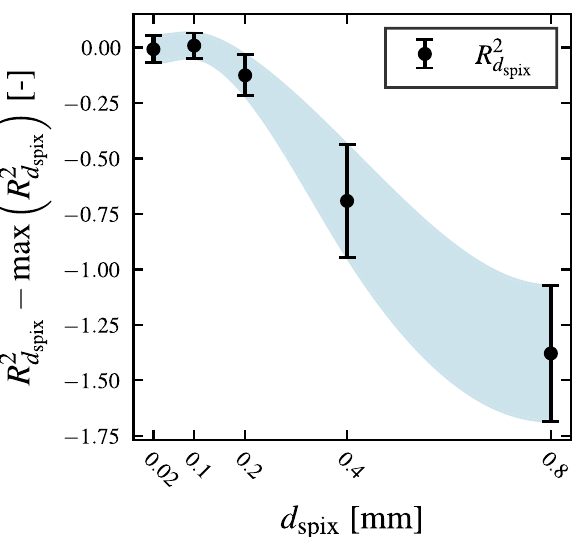
Figure 4. Sparsity constraint for 3D heat flow: Influence of the pixel cluster size d spix on the quality of the presented forward model measured by the determination coefficient R 2 d different patterns at β = 0.5 have been experimentally projected and the resulting temperature field has been compared to the prediction by Eq. (10). The presented data is normalized to the maximum